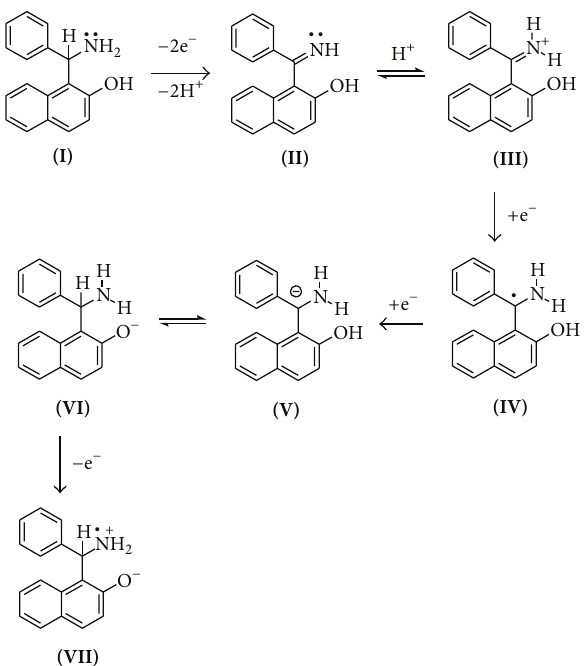
Scheme 1: Proposed mechanism for the redox reaction of